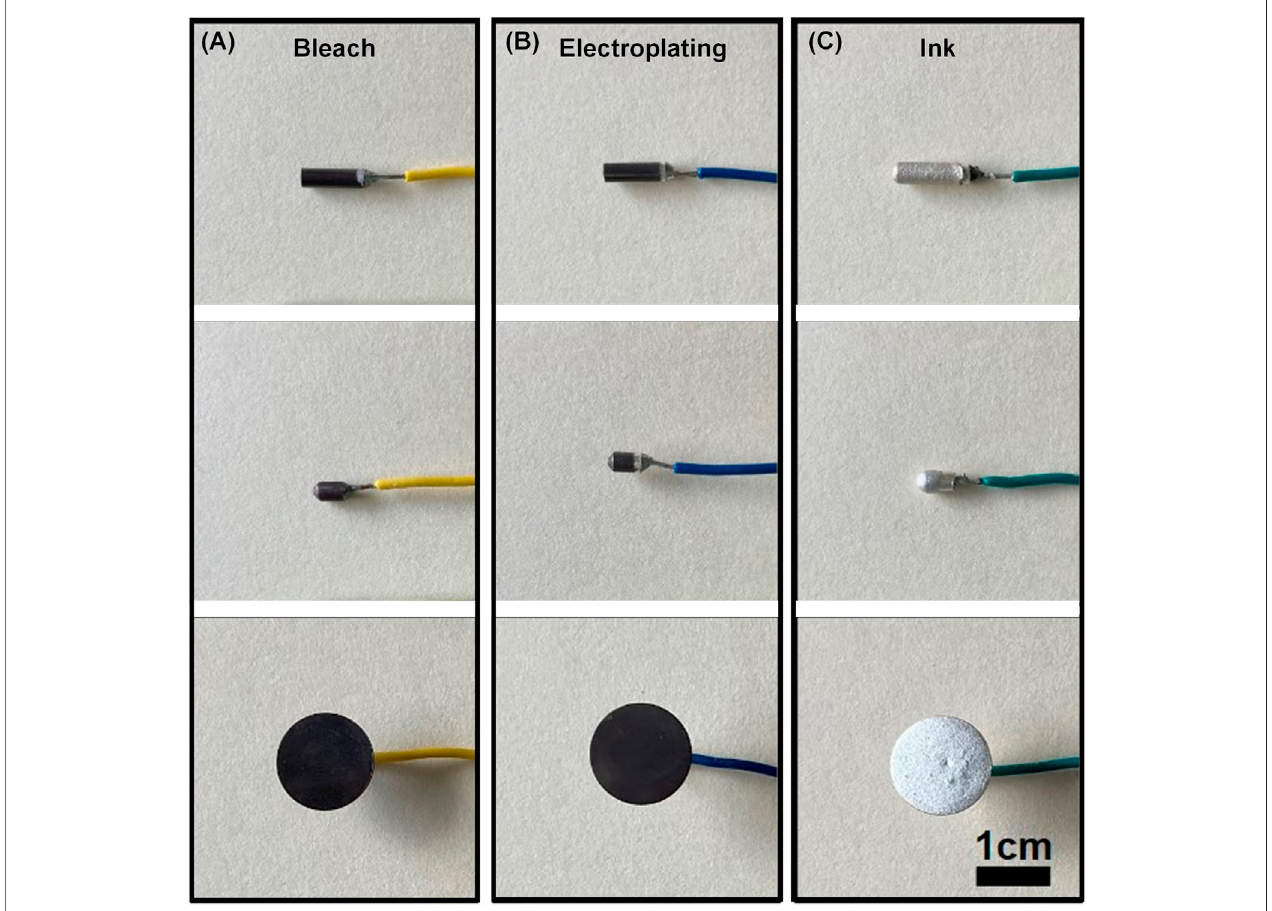
FIGURE6|(A) Ag/AgClelectrodesmadewithdifferentfabricationmethodsfordifferentshapes.Thethreeshapesarerod,bullet,anddiscforthe fi rst,second,and third row, respectively. The bleached, ink, and electroplated electrodes are in the fi rst, second, and third columns from left to right.